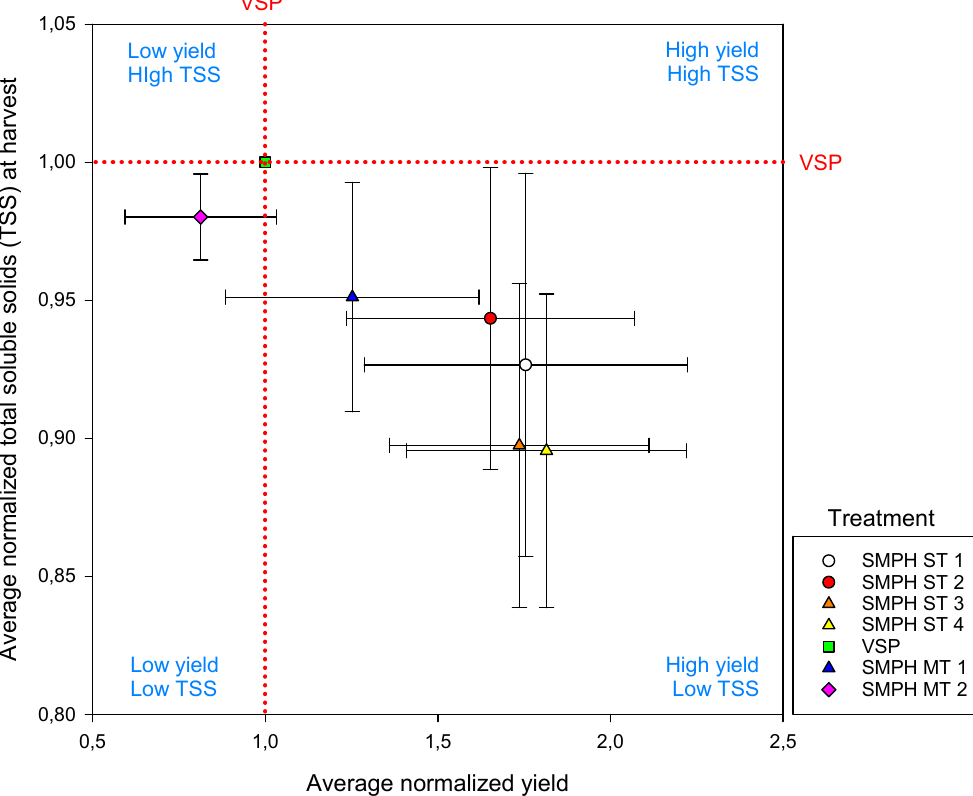
Figure 6. Average normalized yield (ratio of the yield in the different treatments and the yield in the standard treatment, VSP) plotted against the average normalized TSS (ratio of the TSS in the different treatments and the TSS in VSP) at harvest. Data from 2014 to 2018. Error bars = standard errors.